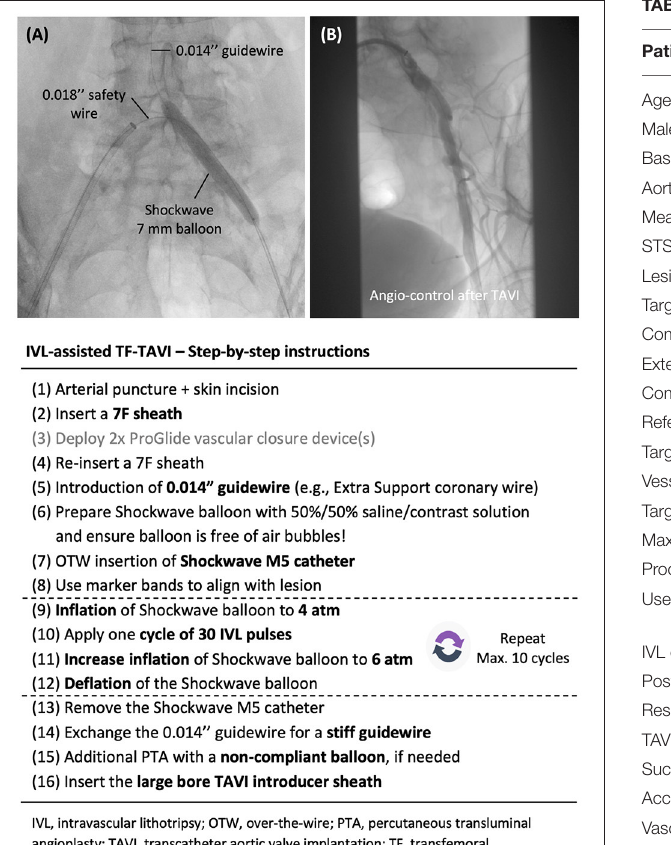
TABLE 1 | IVL-assisted transfemoral TAVI experience in